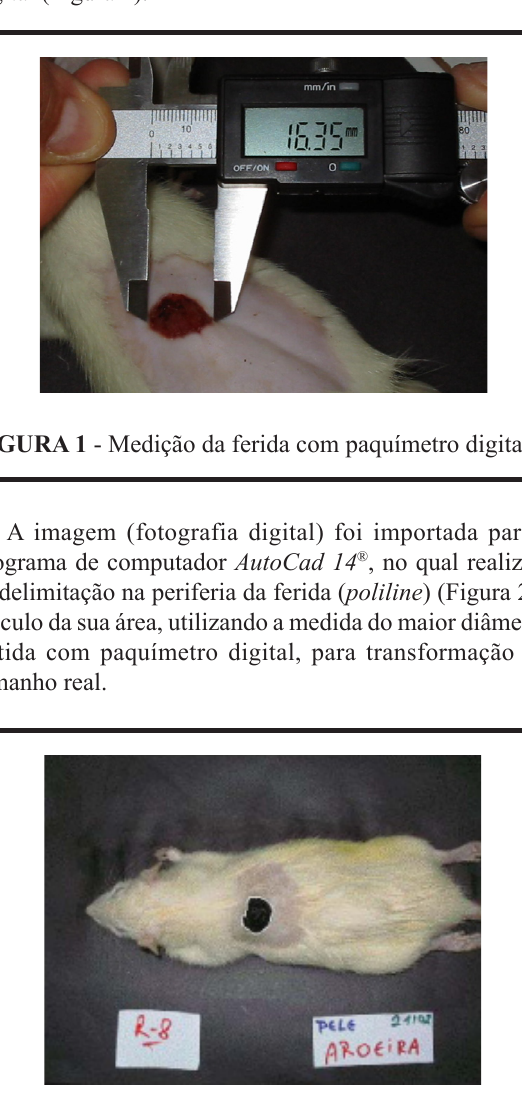
FIGURA 2 - Delimitação da área da ferida no programa AutoCad 1